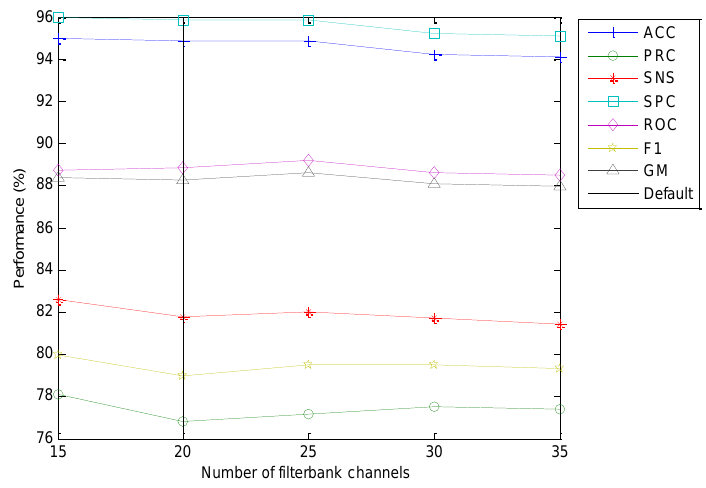
Figure 26. Classification performance metrics of the best classifier vs. the number of filter banks.